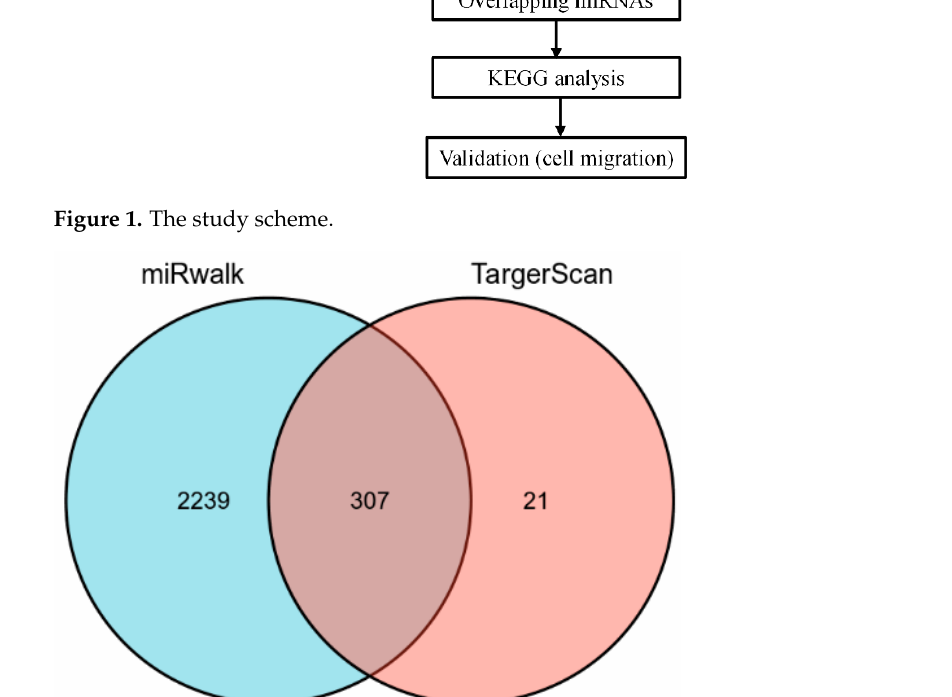
Figure 2. Overlapping predicted miRNAs derived from the miRWalk and TargetScanHuman data- base.